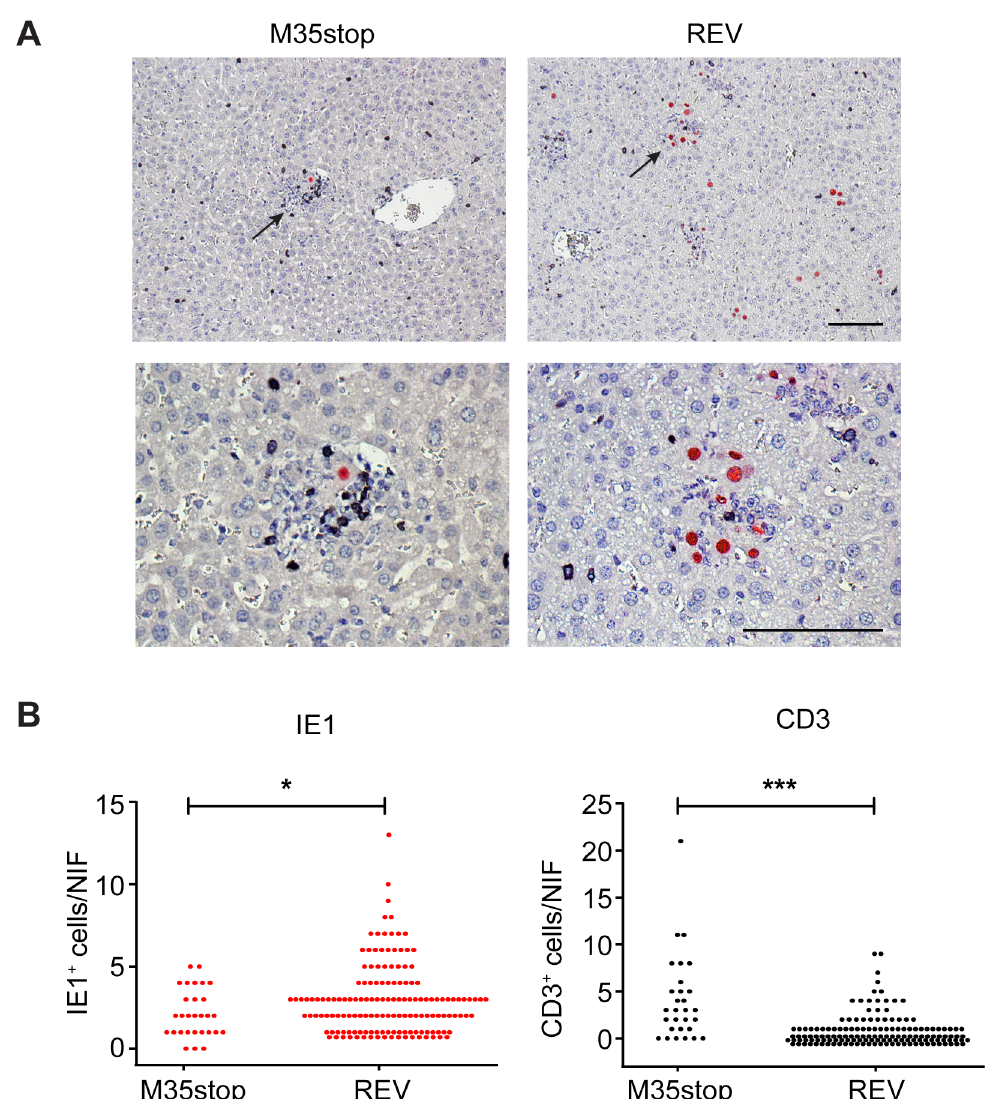
Fig 11. MCMV lacking M35 recruits antiviral CD3 + cells more efficiently to infected IE1 + tissue cells for the formation of protective nodular inflammatory foci (NIF). (A) For the quantification of focal infiltrates in the liver, tissue sectionswere collectedrandomlyfrom four BALB/c mice per group on day 3 after i.v. infectionwith 2 x 10 5 PFU of either MCMV-M35stop (M35stop) or MCMV-M35stop-REV(REV). Sections were stained by 2-color IHC (2C-IHC) for the expressionof intranuclear viral IE1 protein (red staining)in infected liver tissue cells, as well as for the CD3 ε molecule(black staining)expressedby T cells and NKT cells. Sections were counterstained with hematoxylin. Representative low-magnification overviewimages documenting a marked difference in the numbers of NIF (upper panels). Higherresolutionimages of representative foci that are marked by arrows in the overviewimages (lower panels). Scale bars represent 100 μ m. (B) Data quantification and statistical evaluation of differences for representative tissue section areas of 40 mm 2 . Each dot symbol (n = 29 for M35stop and n = 149 for REV) represents a focus of infectionor a NIF in case of CD3 + cell recruitment. P values were calculatedby using the unpairedtwo-tailed Student’s t-test with Welch’s correction to account for unequalvariances. Differencesbetweendata sets are consideredstatistically significantfor * p < 0.05 and *** p < 0.001.